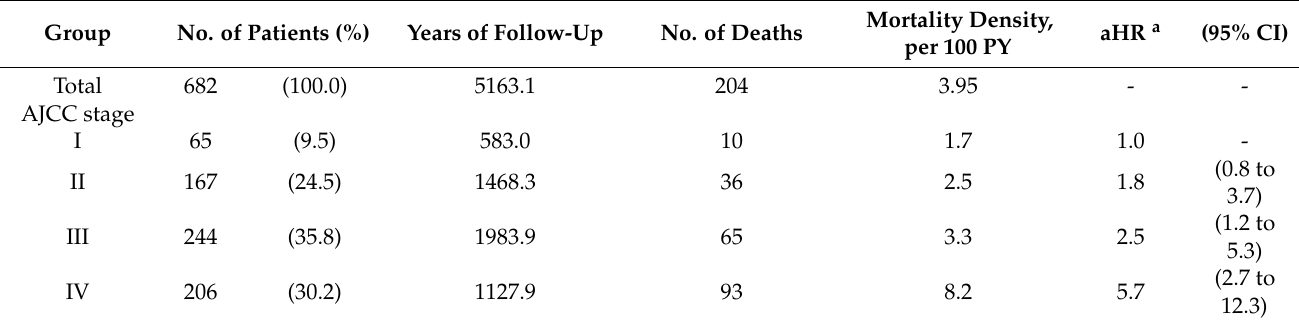
Table 2. Mortality densities and adjusted hazard ratios (aHR) of mortality associated with AJCC tumor stage for nasopha- ryngeal cancer patients after IMRT.